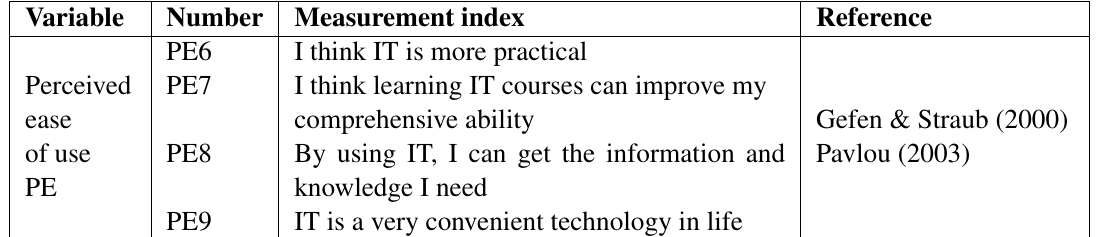
Table 2 Perceptual ease of use